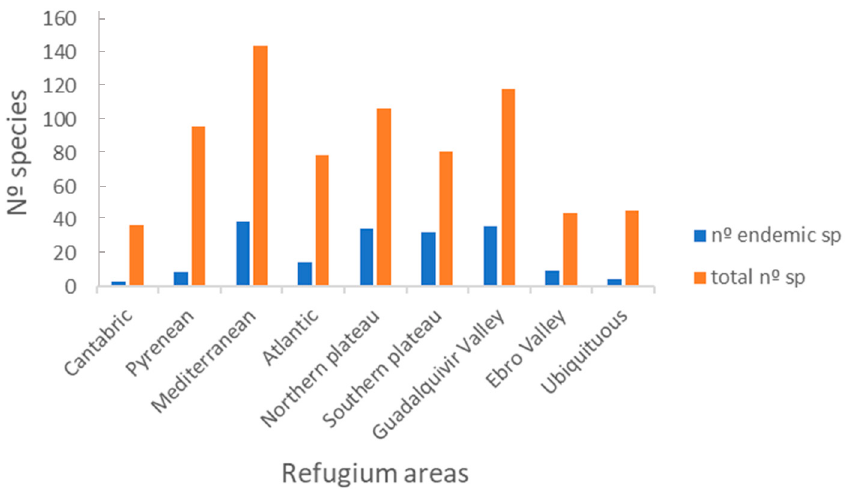
Figure 8. Number of species (orange) and endemism (blue) in the different refugium areas of the IP. Table 4. Number of ant species occupying an increasing number of refugium areas. Nº Occupied Refugium